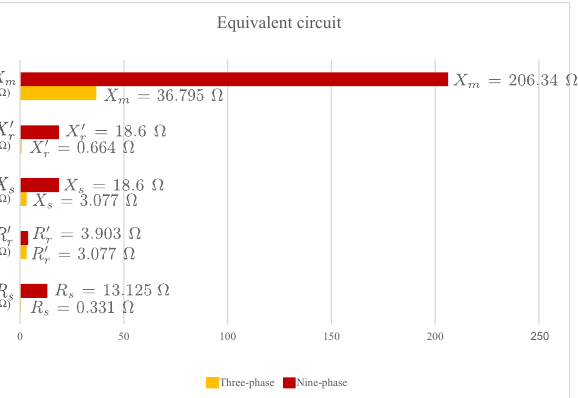
Figure 17. Comparison between the values of resistances and reactances of the equivalent circuit of both three-phase and nine-phase